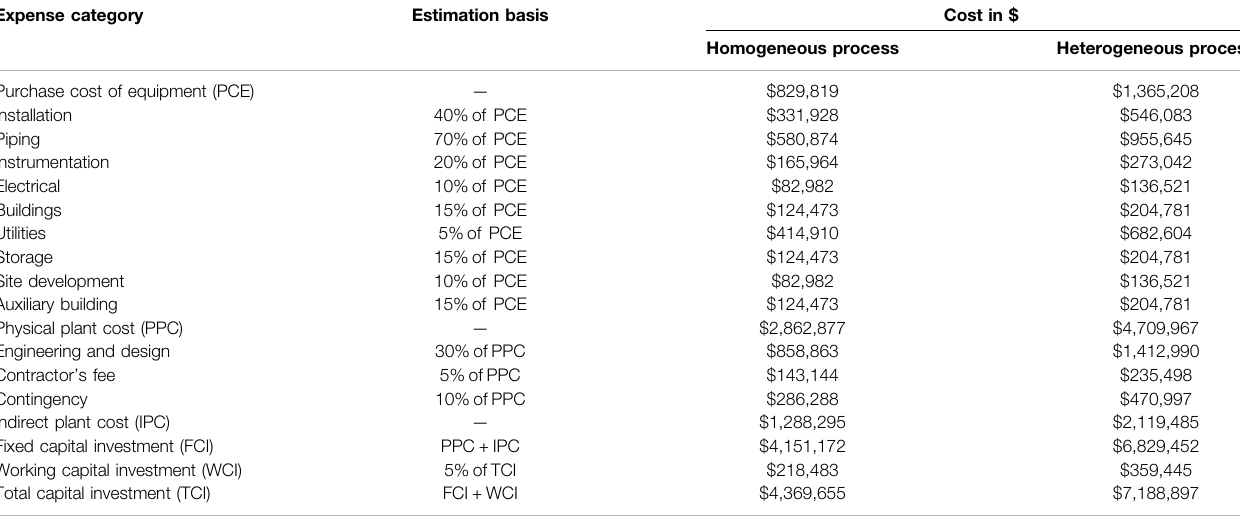
TABLE 2 | Detailed calculations of the physical plant costs, indirect plant costs, and the total capital investments of the homogeneous and heterogeneous processes. Expense category